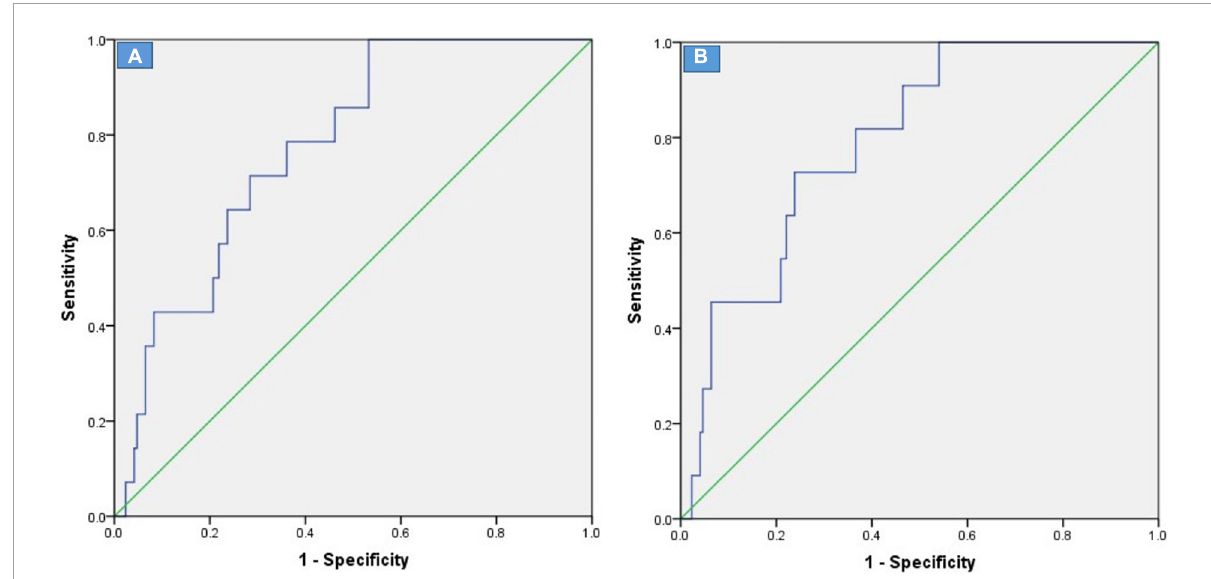
FIGURE4 ROC curves of %LGE for estimated 6-year cardiovascular mortality (A) and SCD events (B) after alcohol septal ablation in patients with obstructive